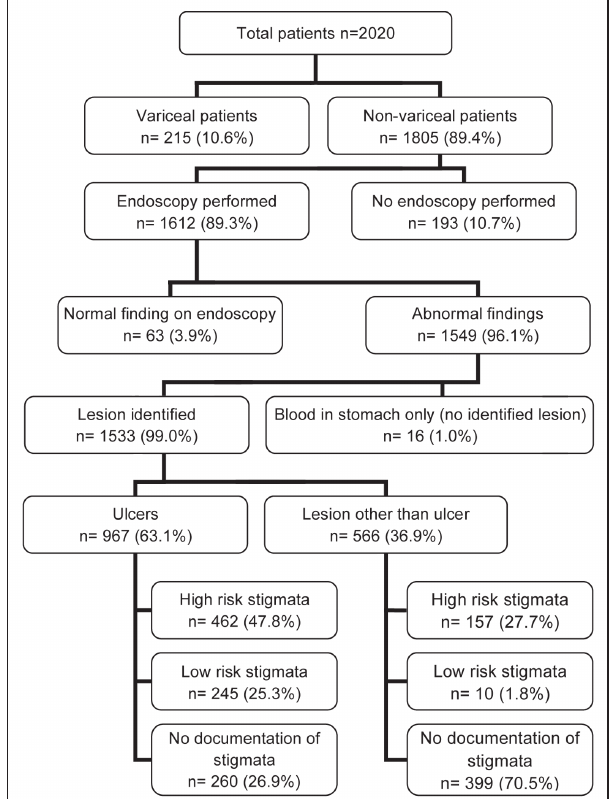
Figure 2) Distribution of patients presenting with acute upper gastrointes- tinal bleeding according to endoscopic findings